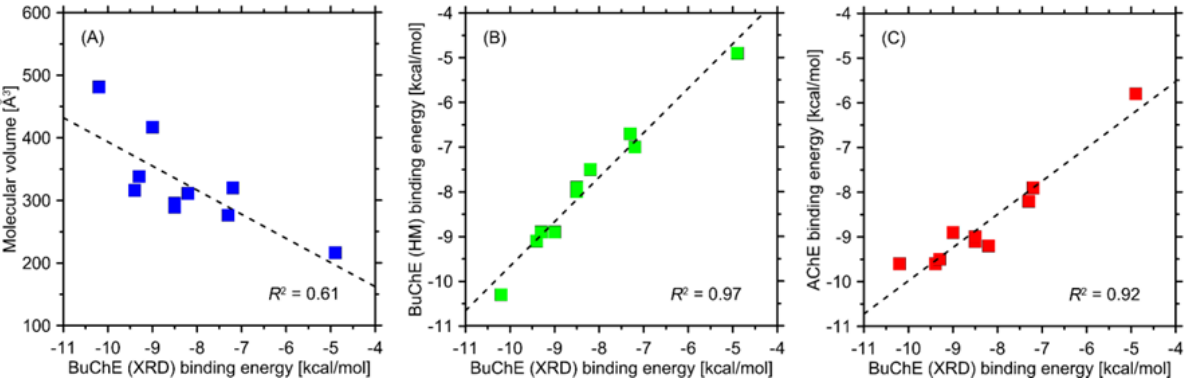
Figure 6. ( A ) Correlation between the average binding energies determined for X-ray crystal structure (XRD) of BuChE and the molecular volume of studied compounds. ( B ) Correlation between binding energies obtained for X-ray crystal structure (XRD) of human BuChE and homology model (HM) of equine BuChE. ( C ) Correlation of binding energies determined for AChE and BuChE and the same set of ligands. Determination coefficients are given as well.